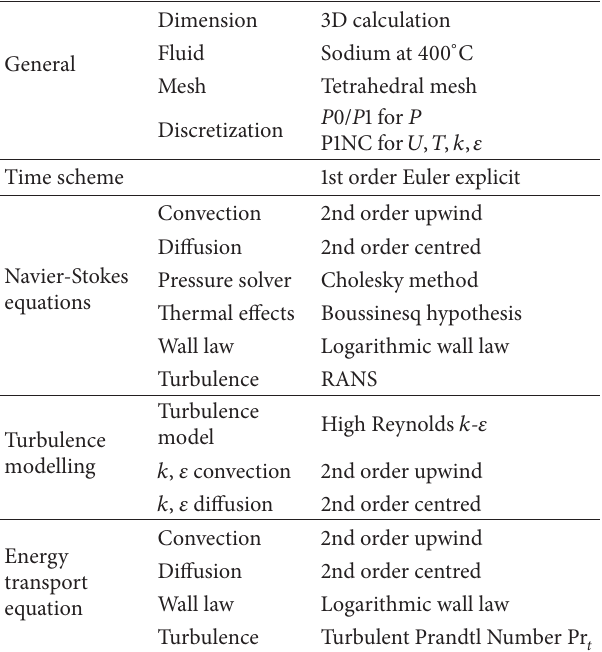
Table 3: Fundamental numerical scheme used in the Trio U calcu- lations.